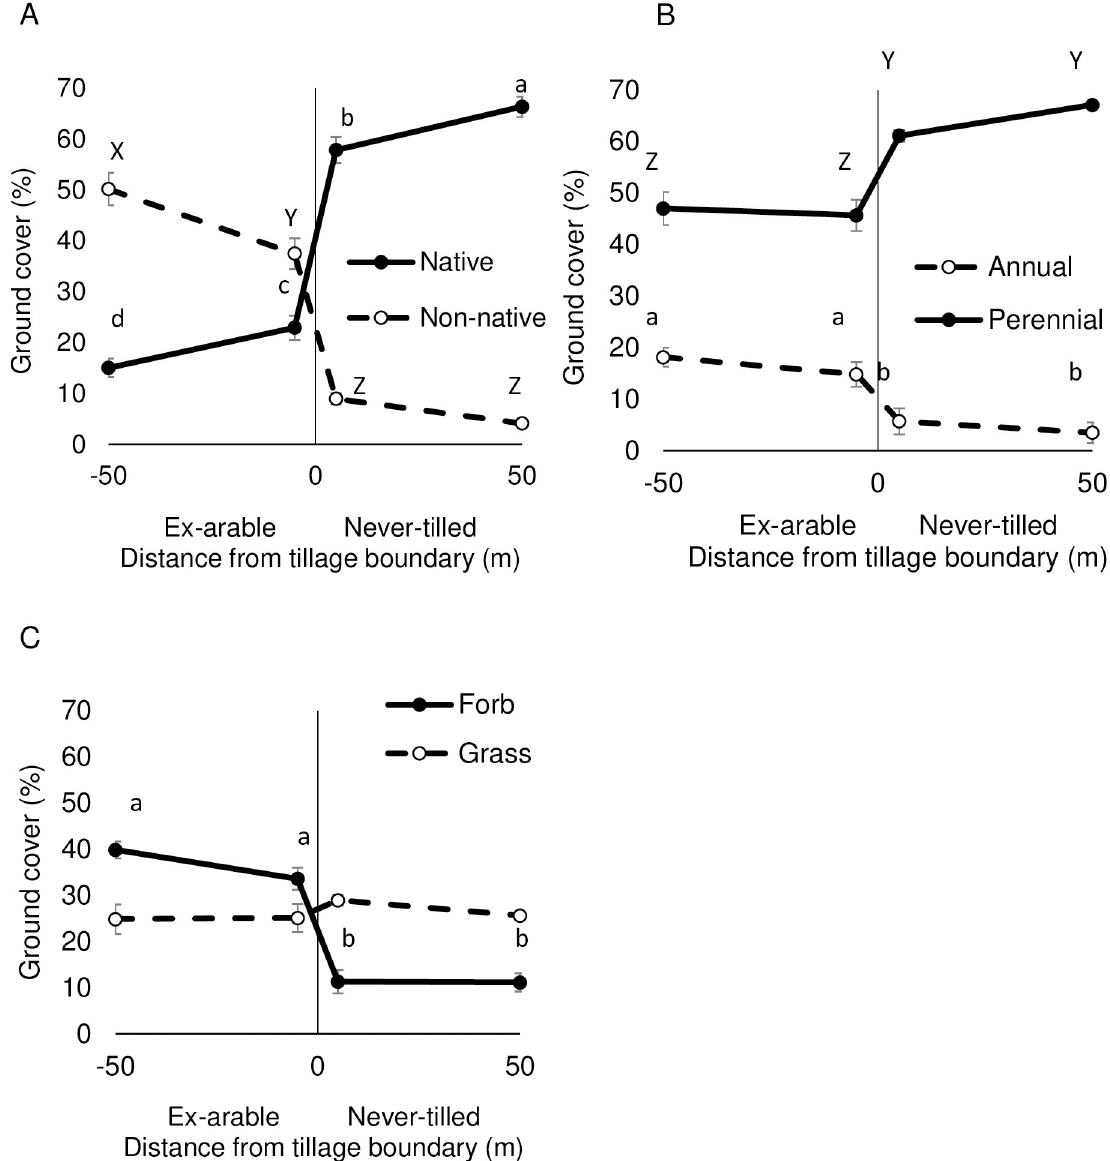
Fig 2. Percent ground cover of (A) native and non-native plants, (B) annual and perennial plants, and (C) forbs and grasses across tillage boundaries. Negative x-axis values are in ex-arable fields. Positive x-axis values are in never-tilled fields. Values represent the mean and standard error associated with the 25 sampled fields (values from replicate plots and years were averaged prior to calculations). Different letters are different at the α = 0.05 level.